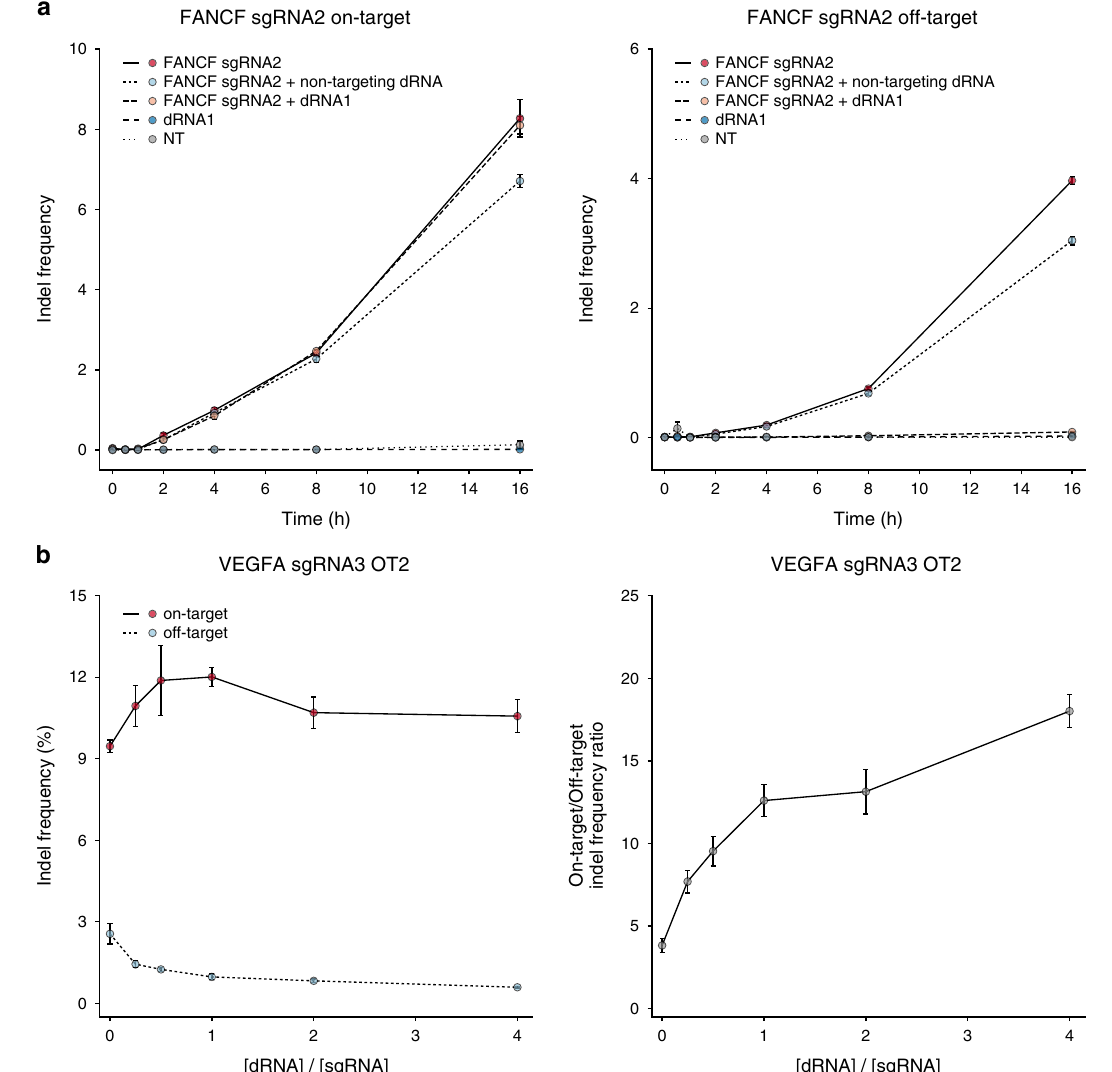
Fig. 3 dRNAs affect off-target, but not on-target, editing kinetics and can be titrated to improve speci fi city. a Editing of FANCF- sgRNA2 on-target and OT1 sites using chemically inducible Cas9 (ciCas9) from 0 to 16 h after activation with A115. Nontargeting dRNA is a 14-base control dRNA targeting a non-endogenous site. NT = non-transfected control. Points depict the mean of n = 3 biological replicates. Error bars show the standard error of the mean. b Indel frequencies and speci fi city ratios at VEGFA sgRNA3 on-target and OT2 sites in cells transfected with plasmids encoding Cas9 and varying ratios of VEGFA sgRNA3 and dRNA2. dRNA untreated cells were transfected with Cas9 and a 1:1 VEGFA sgRNA3:GFP plasmid ratio. Error bars depict s.e.m. ( n = 3 cell culture replicates). OT off-target. Source data are available in the Source Data fi